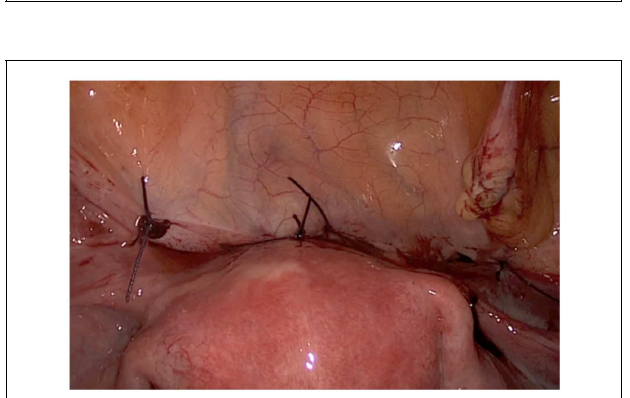
FIGURE 4 |Ablation of the ectopic pregnancy after hysterotomy .